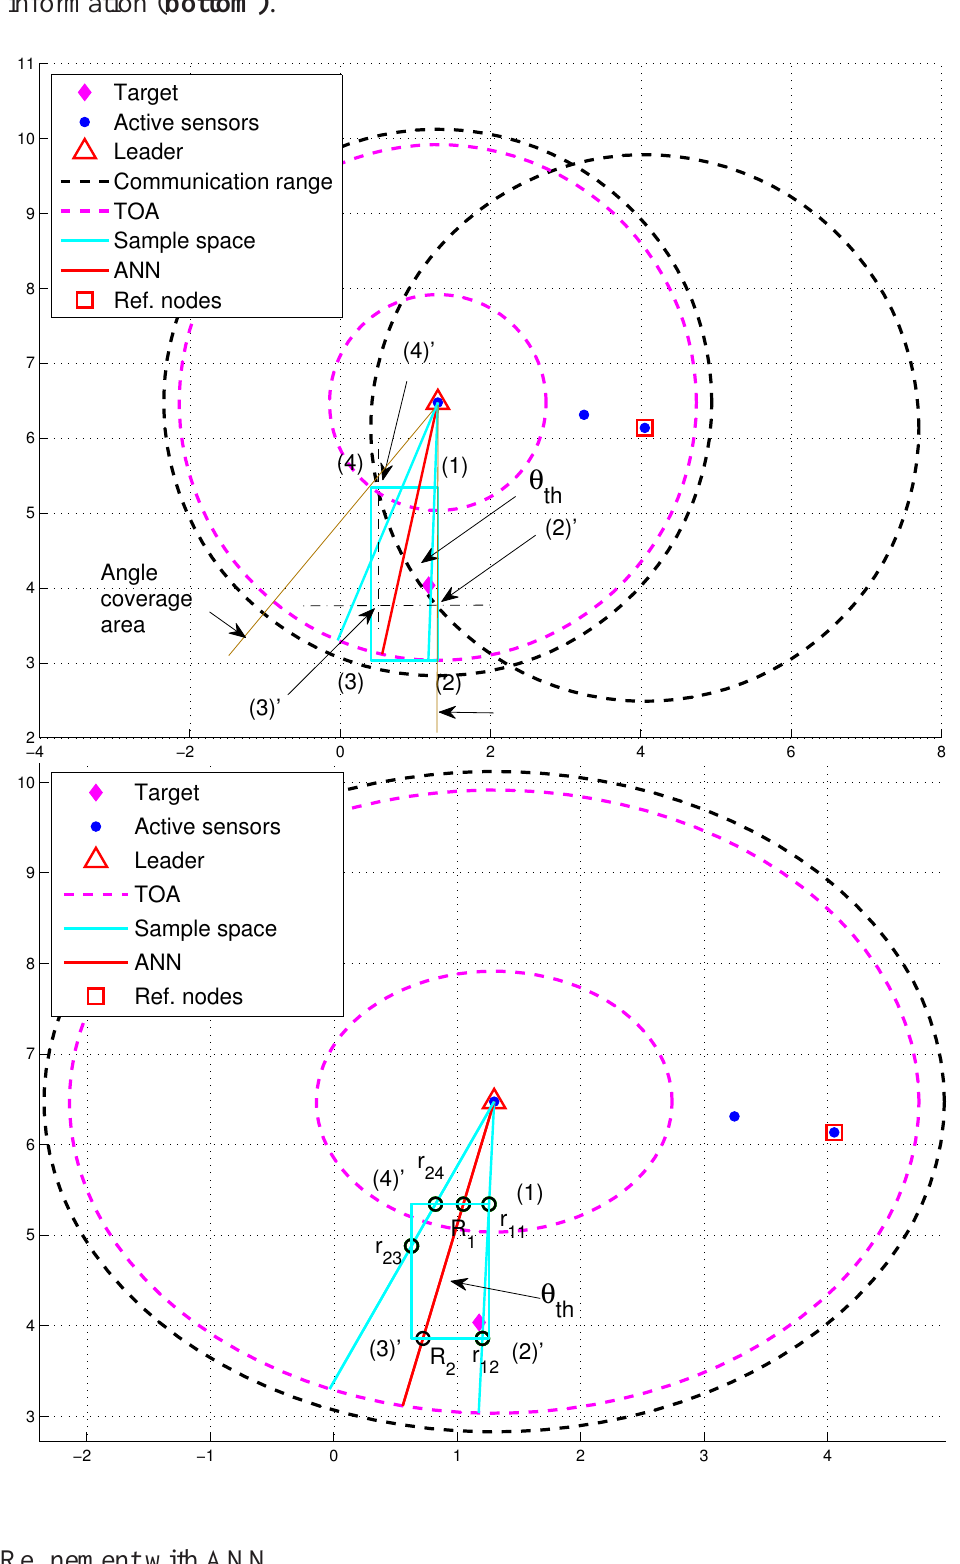
Figure 5. The initial sample area ( top ); the refined bounding box based on the reference angle information ( bottom)